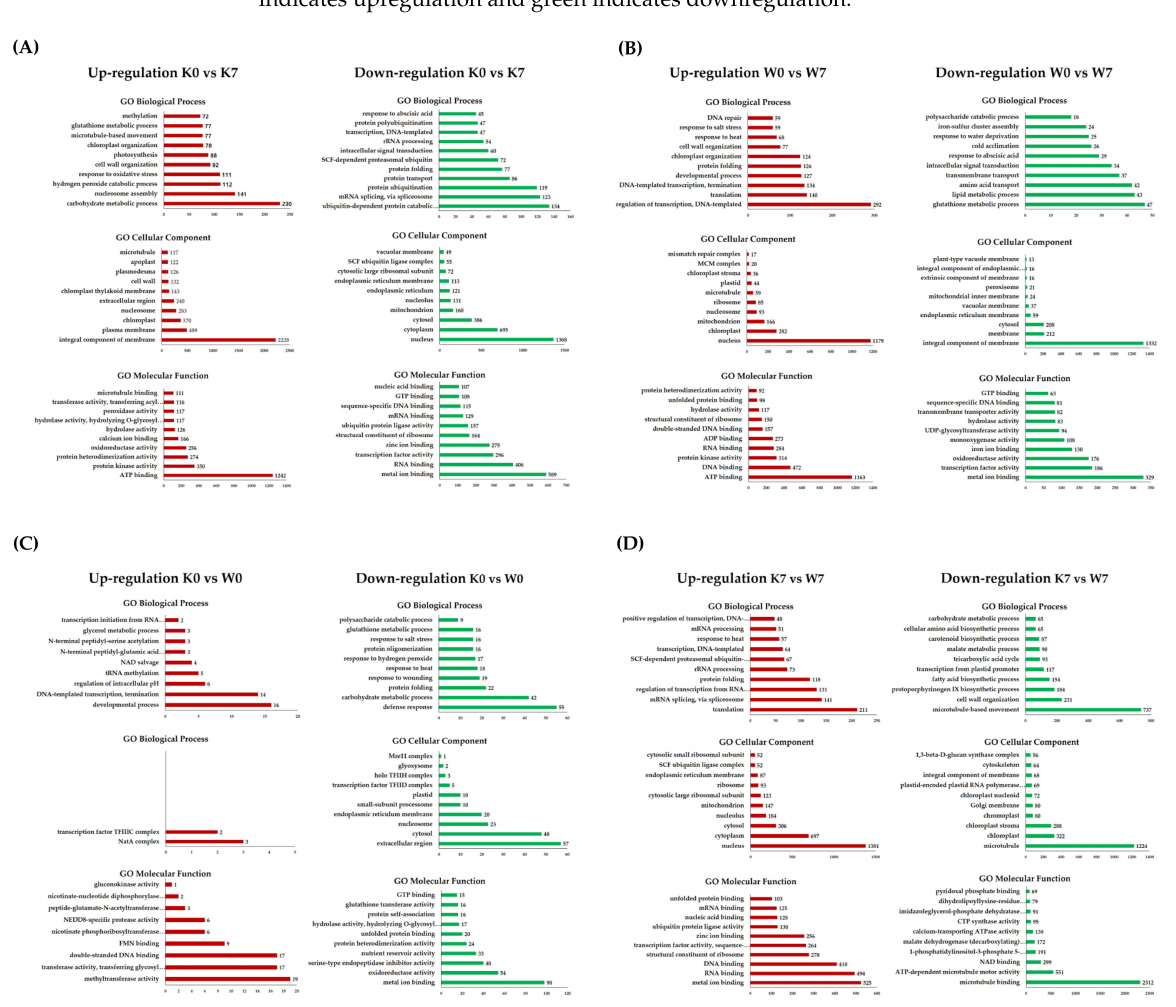
Figure 3. Gene Ontology analysis in DEGs for the K0 vs. K7, W0 vs. W7, K0 vs. W0, and K7 vs. W7 groups. Upregulation (red) and downregulation (green) are shown for each group, and GO terms belonging to the categories of biological processes, cellular components, and molecular functions are indicated. The X -axis represents the number of annotated DEGs, and the Y -axis lists the 10 most annotated GO functions by category. ( A ) Annotated up-/downregulated GO terms in K0 vs. K7. ( B ) Annotated up-/downregulated GO terms in W0 vs. W7. ( C ) Annotated up-/downregulated GO terms in K0 vs. W0. ( D ) Annotated up-/downregulated GO terms in K7 vs. W7. The volcano plot is expressed as a p -value derived from the log 2 fold change of the expression value for each comparison group and the average comparison between the two groups. The X -axis represents log 2 fold change; the Y -axis represents − log 10 p -value. Heatmap analysis was performed on differentially expressed proteins in each comparison